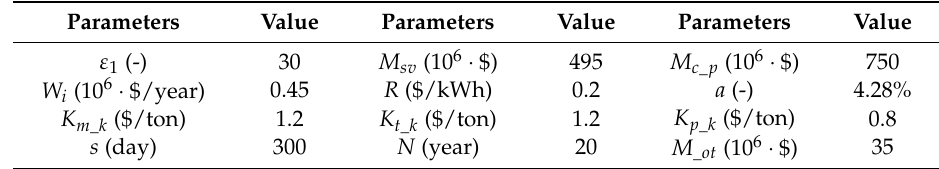
Table 2. The Calculation Parameters Used for the Economic Comparison Partially Based on References [12,17].